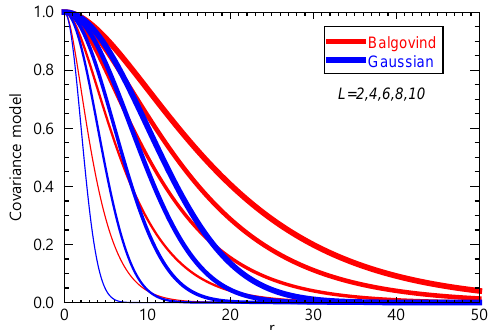
Figure 5. Covariance distribution for Gaussian (blue) and Balgo- vind (red) functions with respect to the distance ( r ) and the values of radius of influence ( L